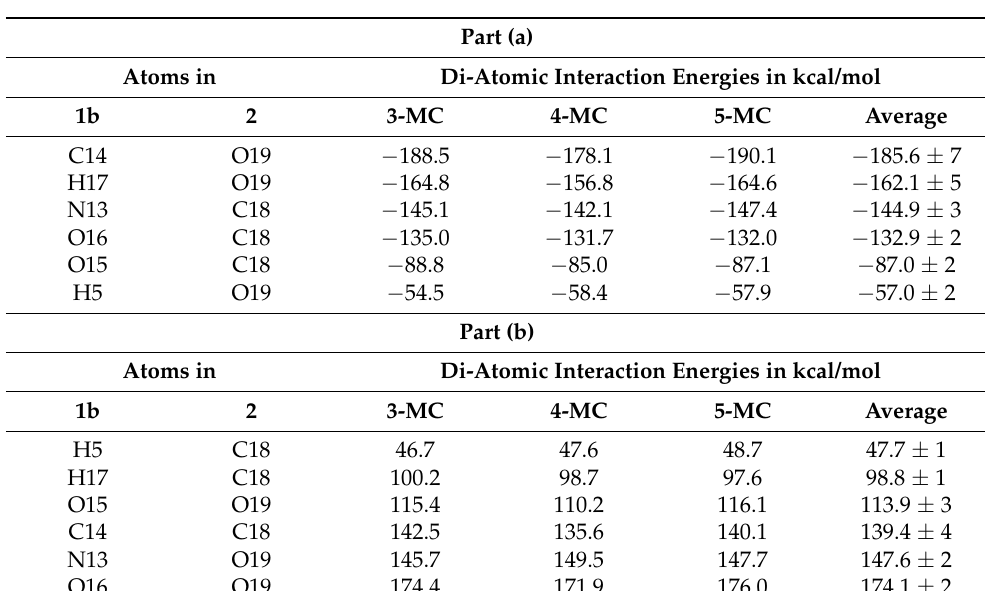
Figure 4. Ball-and-stick representation of 3-molecular complexes involving, besides acetone 2 and a DMSO solvent molecule 3 , the lowest energy conformer (LEC, part ( a )) and higher energy conformer (HEC, part ( b )) of proline 1 . The diatomic interaction energies with standard deviations represent average values obtained for 3-, 4-, and 5-molecular complexes with, respectively, one, two, and three explicit DMSO molecules. Table 1. Strongest diatomic attractive (part (a)) and repulsive (part (b)) interaction energies between atoms of the higher energy conformer of proline 1b and a molecule of acetone 2 in 3-, 4-, and 5-molecular